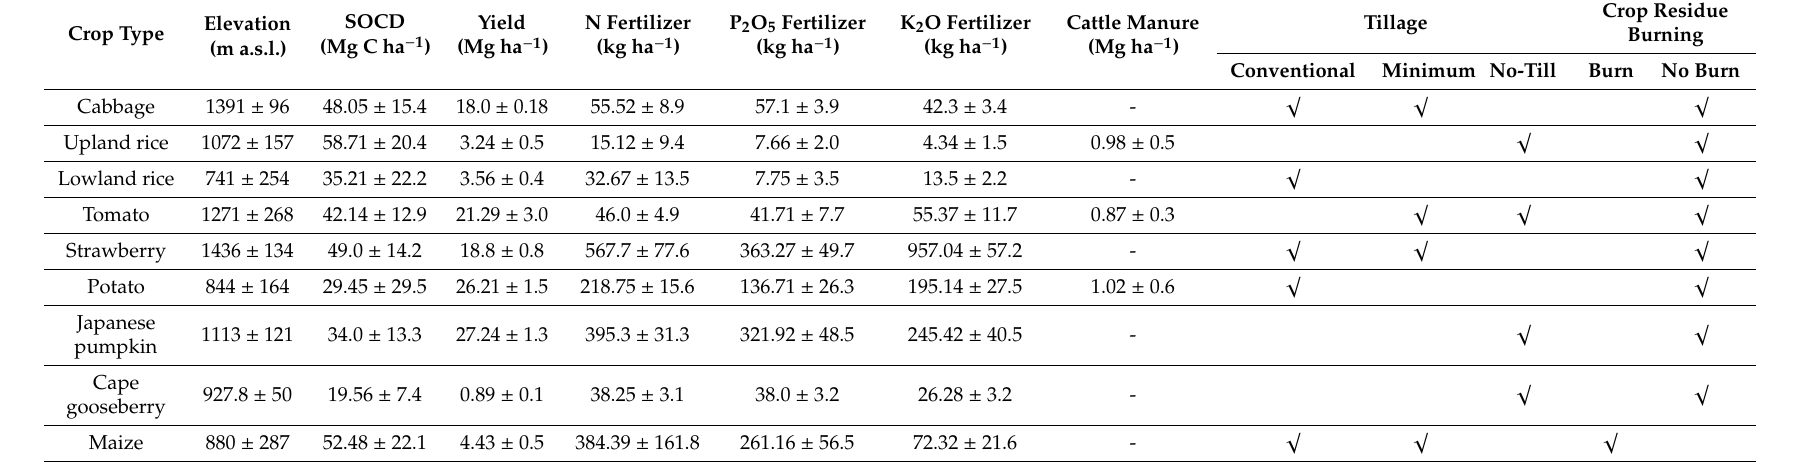
Table 3. Means and standard deviations of elevation, SOCD, crop yields, and management